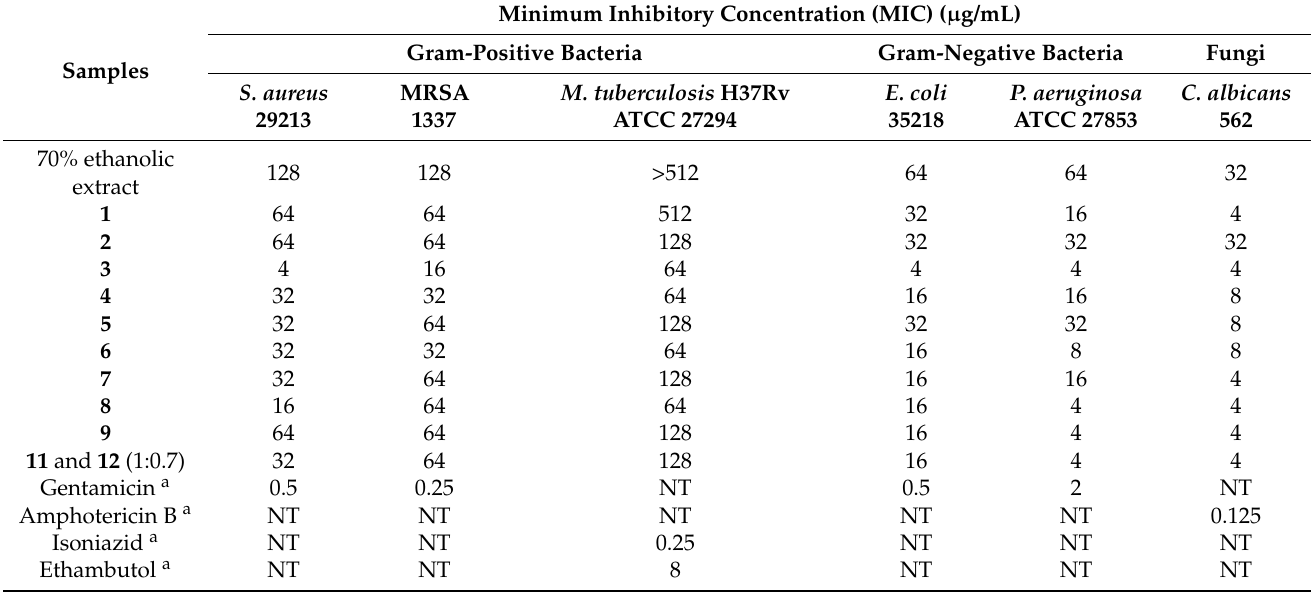
Table 4. Antibacterial and antifungal activities of the total 70% ethanolic extract and isolated